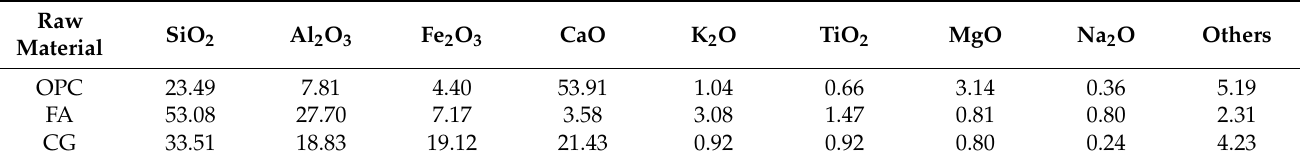
Table 1. Chemical composition of raw materials, in weight